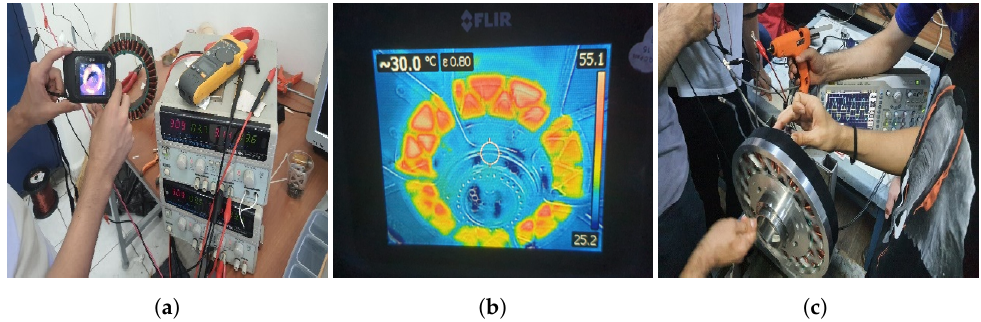
Figure 21. ( a ) Checking the phases with the thermal camera. ( b ) Positioning of the position sensor. ( c ) Positioning of the position sensor.